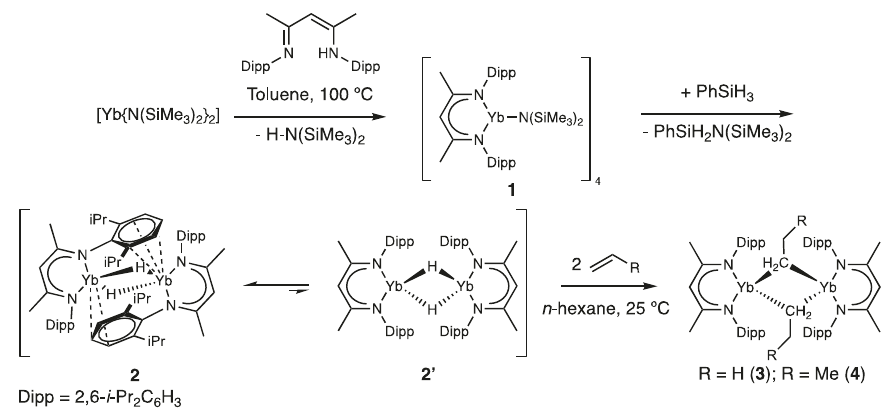
Fig. 2 Synthesis of compounds 1 – 4. Addition of PhSiH 3 to compound 1 provides compound 2 . Reaction of compound 2 with either ethene or propene